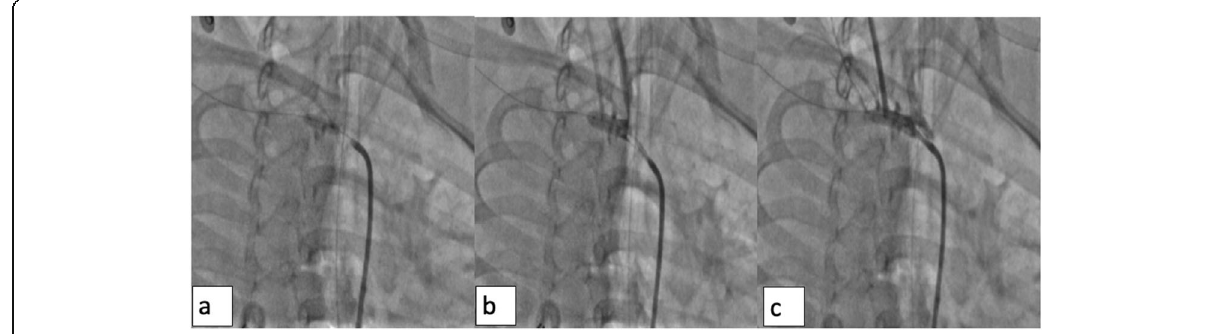
Fig. 2 a BMW 0.014 ″ guidewire parked in the right axillary artery. b 3.0 × 12, 3.5 × 12, 4.0 × 12 mm SC/NC coronary balloons to occlude the